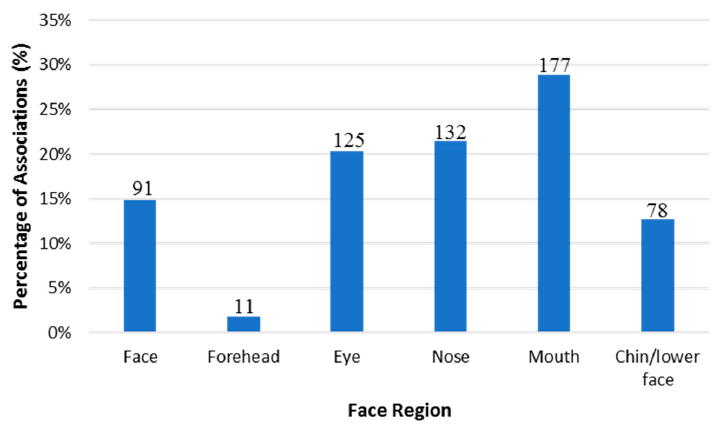
Figure 3. Percentage of SNPs that met the GWAS significance threshold in the GWAS Catalog according to six facial regions (Face, forehead, nose, mouth, lip, and chin/lower face). “Face” indicates traits that were associated with multiple facial regions. Numbers on each bar reflect the number of the associations for each facial